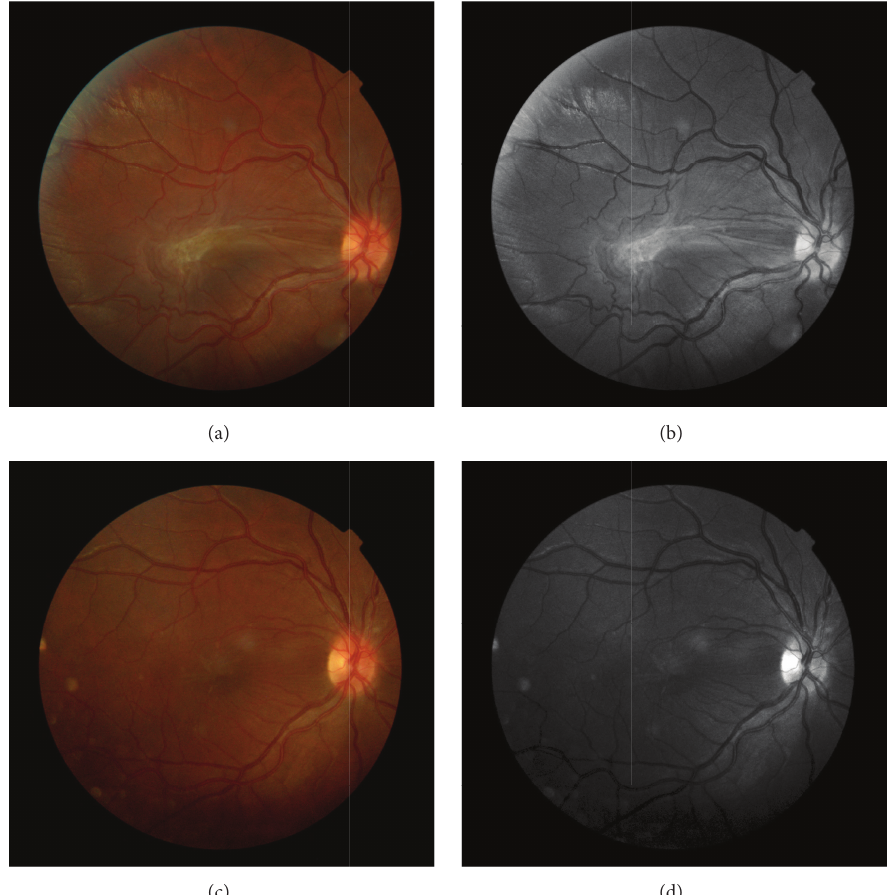
Figure2:(a)Colorretinographyoftherighteyeand(b)reedfreeimageatinitialpresentation.Anelevatedmacularlesion,slightlypigmented, with vascular tortuosity and associated epiretinal membrane, is observed. (c) Retinography of the right eye and (d) reed free image 18